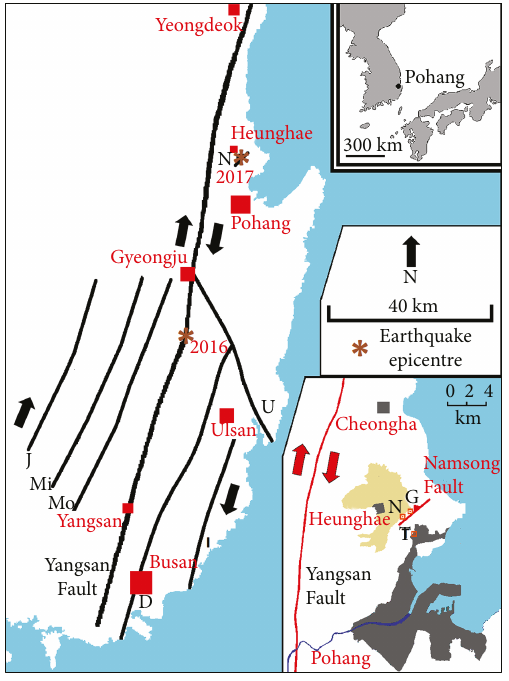
Figure 1: Location map for the city of Pohang in the SE part of the Korean peninsula (upper inset showing wider location, lower inset showing greater local detail), showing Late Cenozoic right-lateral faults (from [96]), the Namsong Fault (from [7]), and the epicentres of the 12 September 2016 and 15 November 2017 earthquakes (from [7, 46]). The right-lateral faults depicted follow prominent fault-line escarpments that dominate the local topography, being readily visible on topographic maps and satellite imagery (such as Figure 1 of [96]). The local inset shows the Namsong Fault (depicted schematically at the updip limit of coseismic reactivation in 2017, from [6]), the Heunghae alluvial plain (pale shading), the EGS project site (G), Namsong village (N), and the Pohang thermal spa resort that yielded hydrochemical data (T; coordinates from